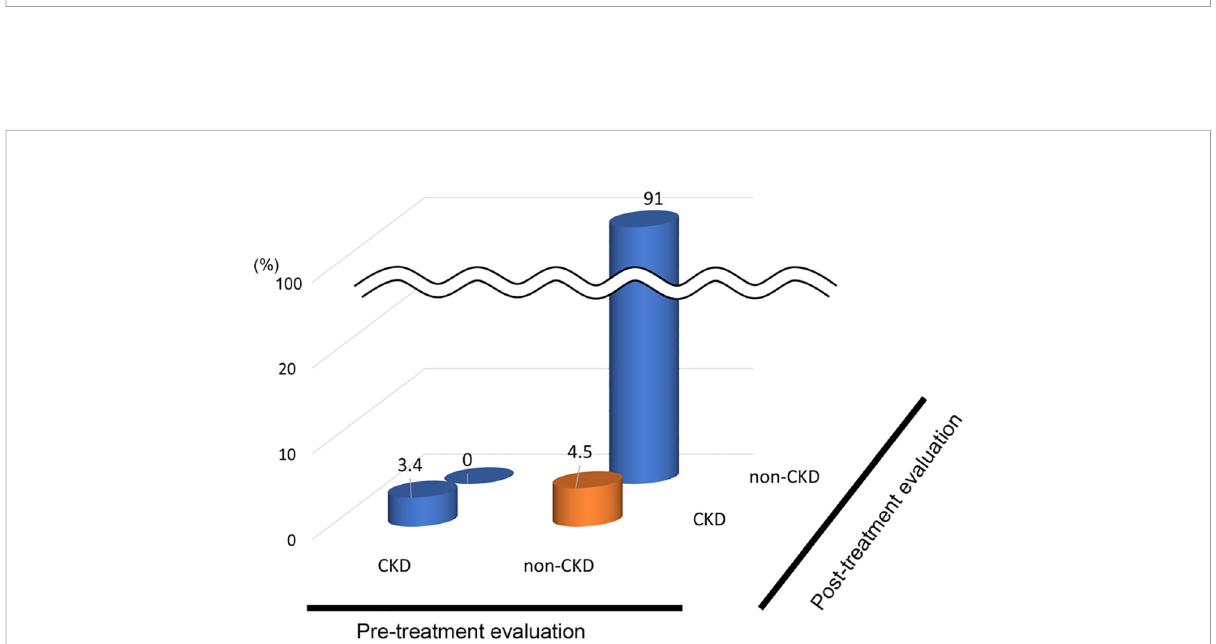
FIGURE 3 Population of “ Masked ” CKD in hyperthyroidism. Hyperthyroidism: 4.5% Masked CKD in a total of 7.9% of real-CKD, indicating 57% of CKD was masked).